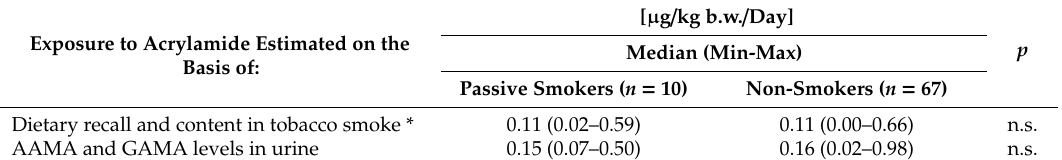
Table 4. Comparison of acrylamide exposure to acrylamide of non-smoking and passive smoking women during pregnancy, estimated on the basis of a 24-h dietary recall and on the AAMA and GAMA levels in urine